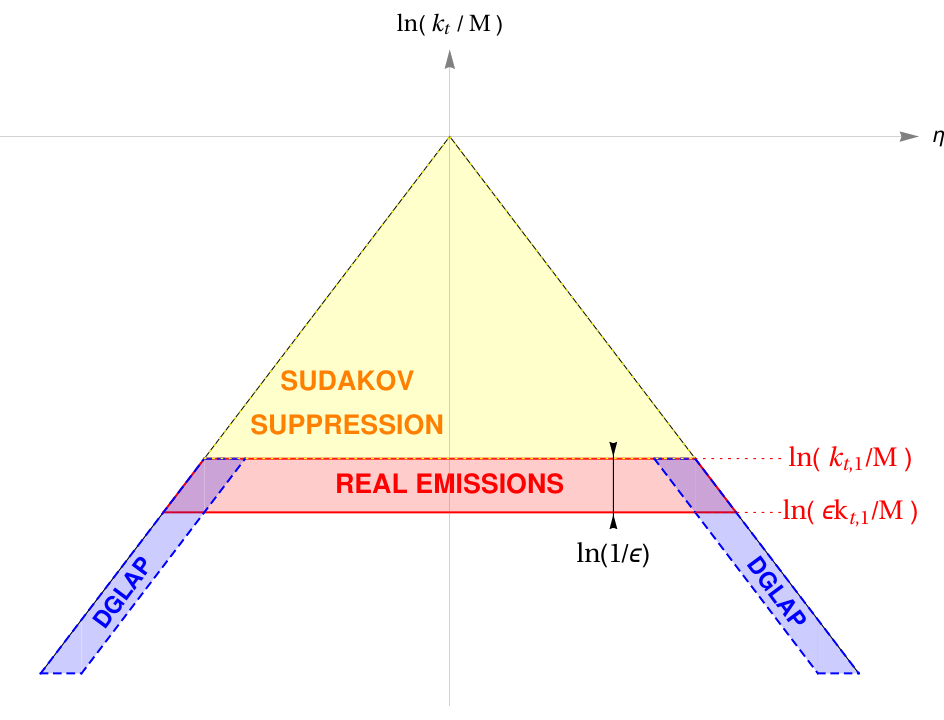
Figure 1 . Phase space for a secondary real